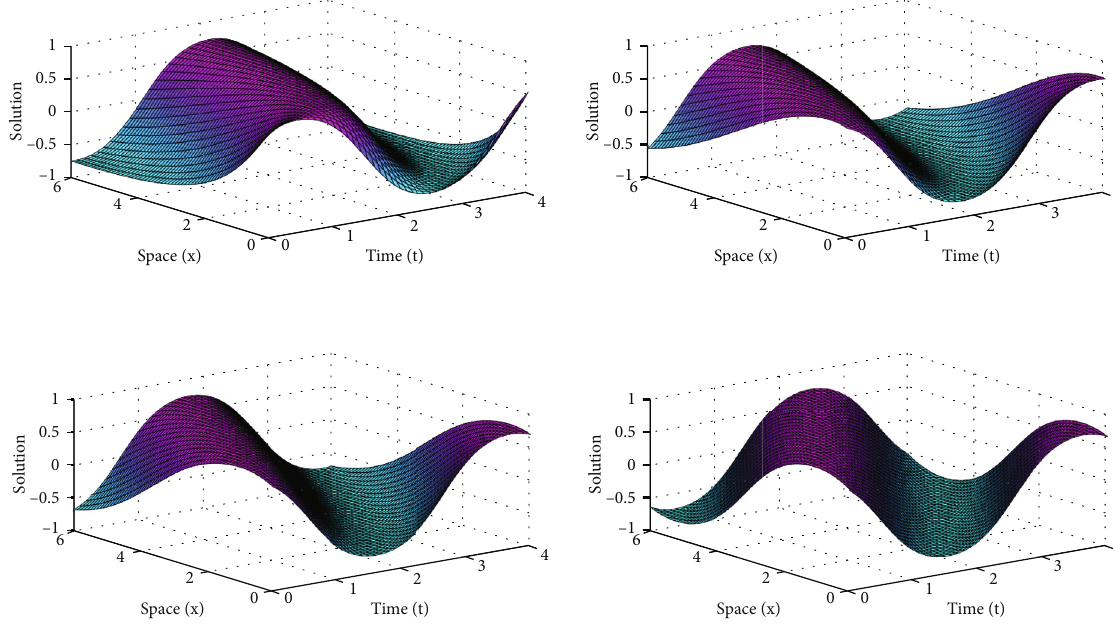
Figure 3: 3D diagram of Equation (25) with σ = 0 and various β .